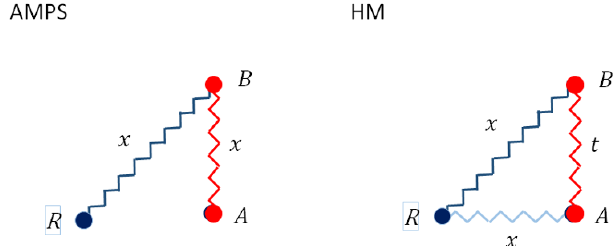
Figure 7 . In AMPS (left (cid:12)gure) we have spatial entanglement ( x ) between late time outgoing Hawking radiation B and both the early radiation R and its infalling Hawking partner A . This violation of entanglement monogamy leads to causality violations using just measurements on the individual systems. If instead the spatial entanglement on AB becomes entanglement in time, then AR also becomes spatially entangled (right (cid:12)gure), and then the correlations obtained do not lead to such paradoxes. The entanglement structure of the right (cid:12)gure corresponds to a temporal product between A and B as is found in the HM